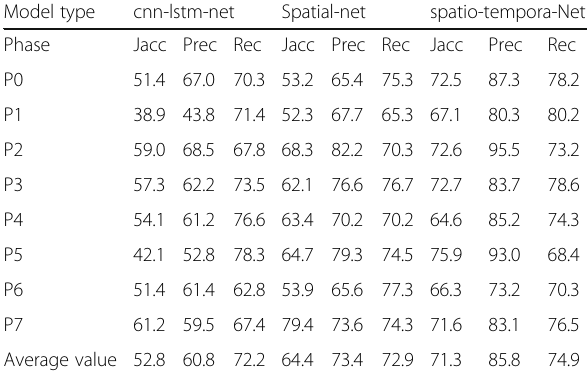
Table 2 Phase recognition results Model type